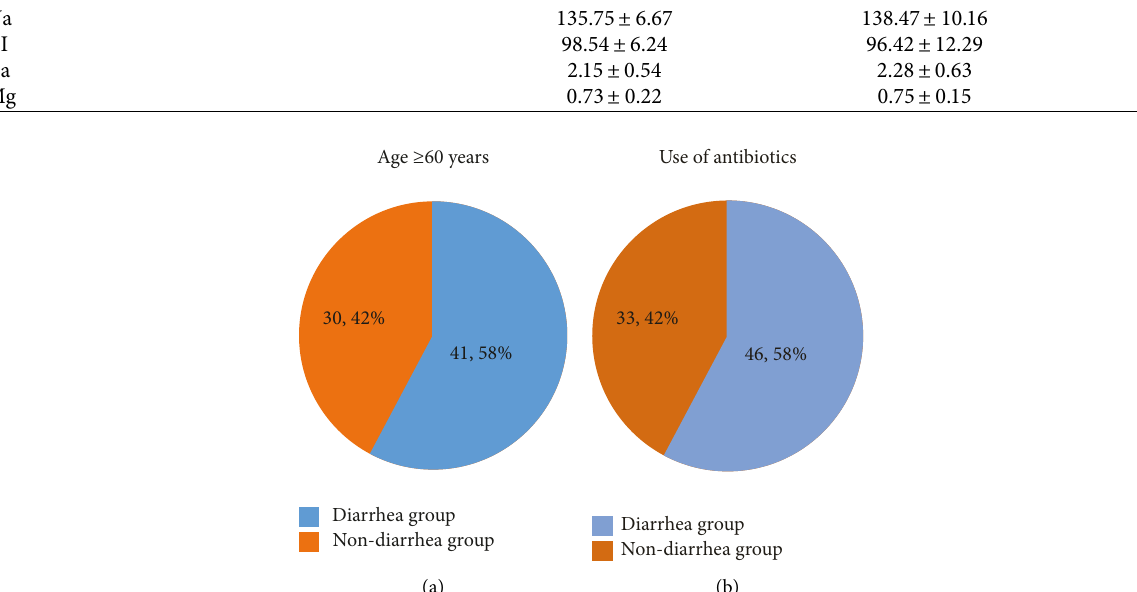
Figure 2: Proportion of diarrhoea cases in patients aged ≥ 60 years and on antimicrobials. (a) Proportion of diarrhea in patients aged ≥ 60 years old. (b) Proportion of diarrhea in patients using